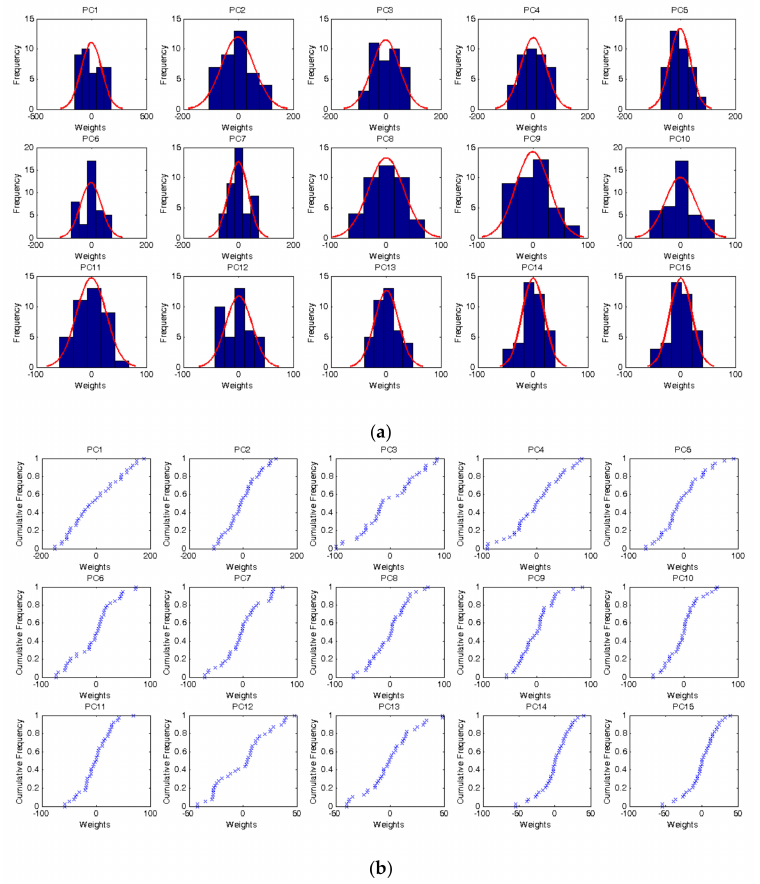
Figure 5. Empirical Frequency ( a ) and cumulative frequency ( b ) distributions of weights for each principal component, with reference to the 40 mandibles